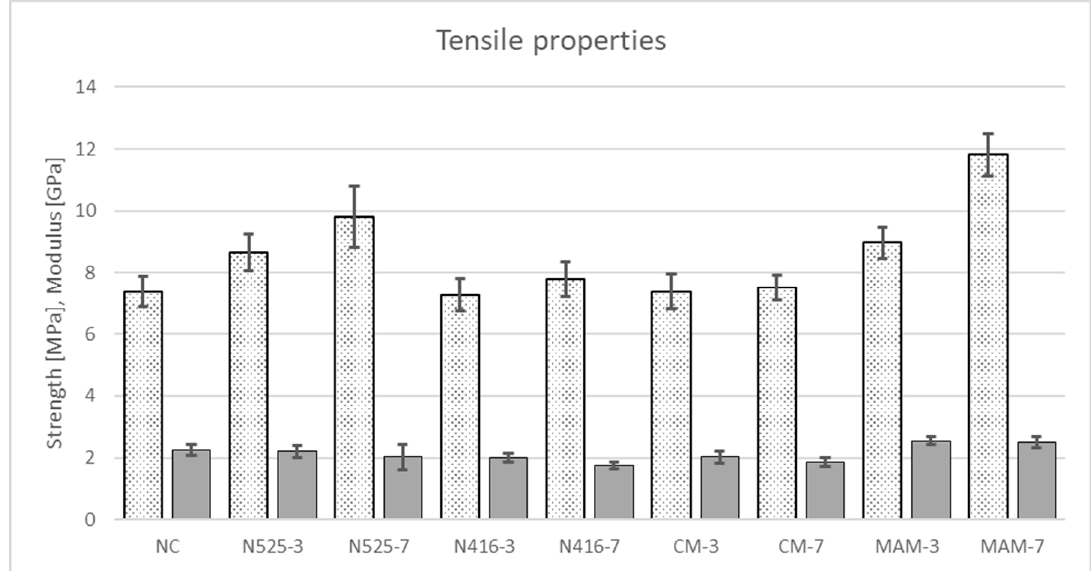
Figure 6. Tensile properties. Strength on the left side (light shaded bar) and modulus on the right (dark bar).